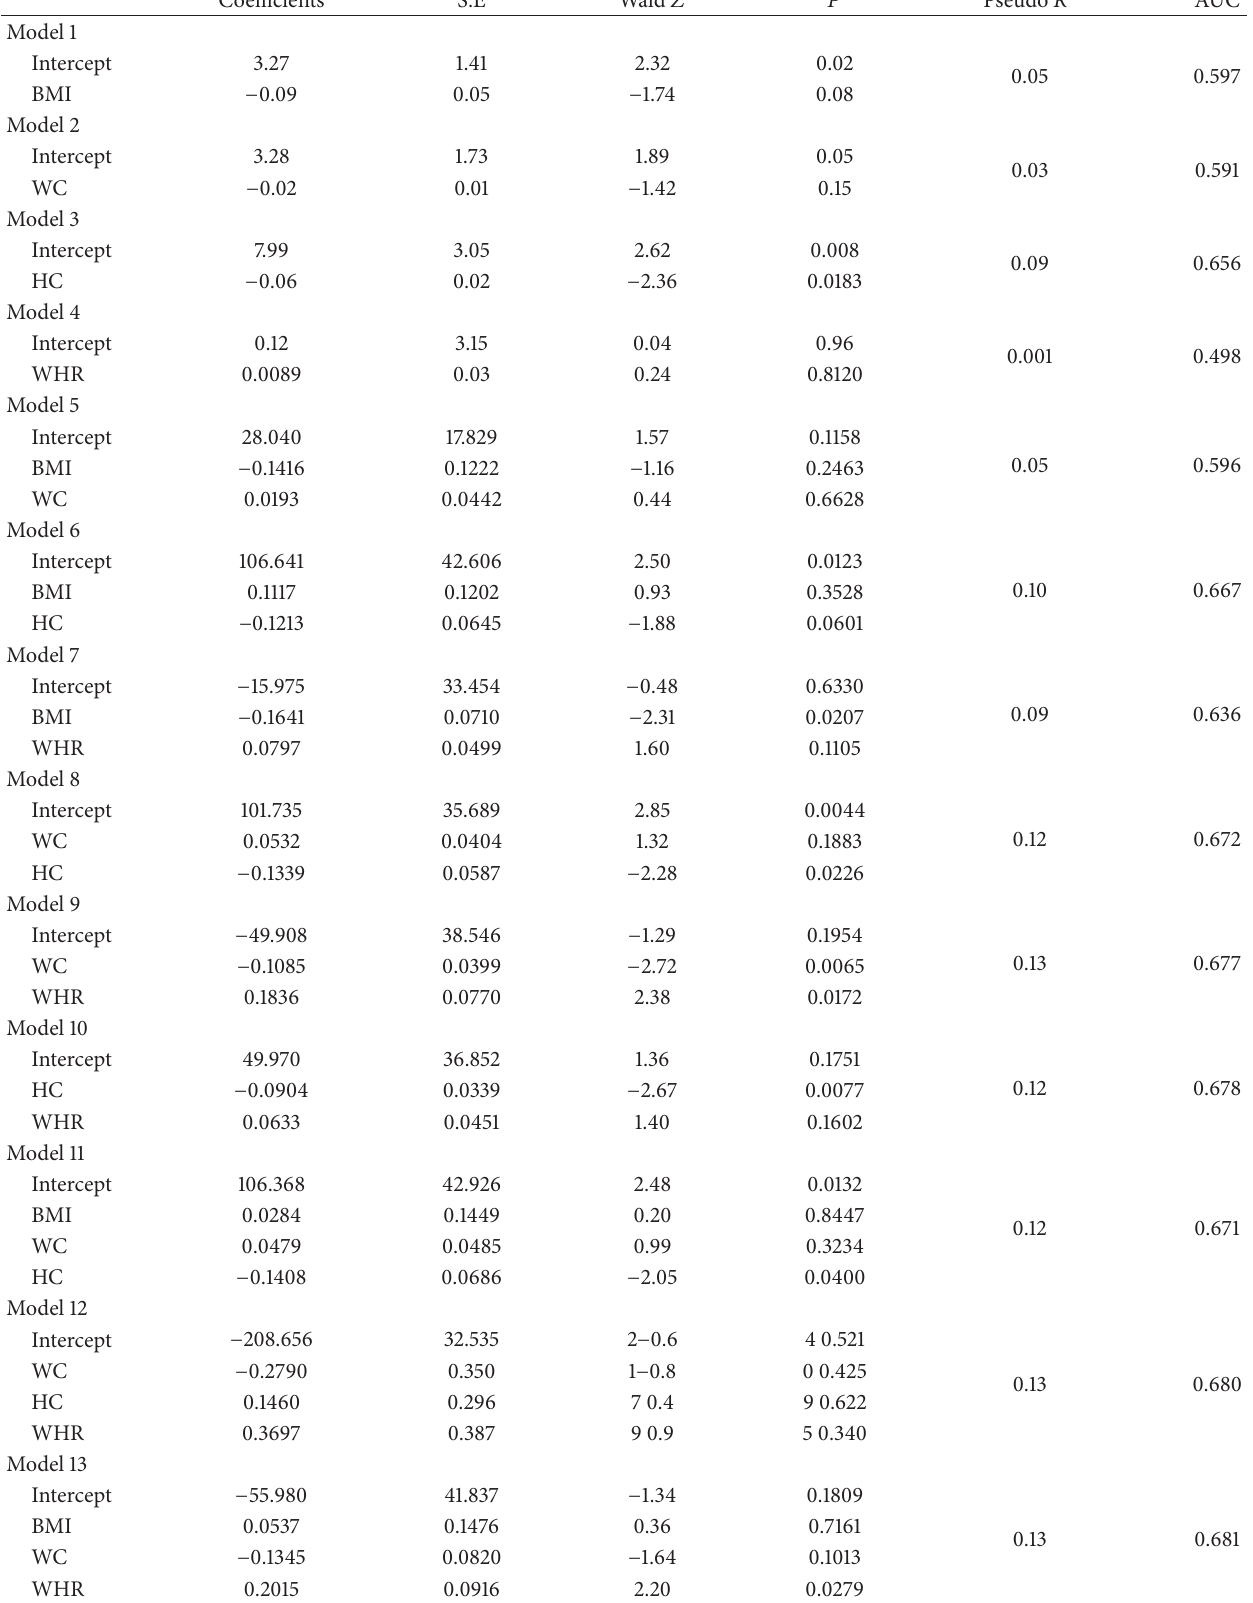
Table 4: Logistic regression results of men’s training